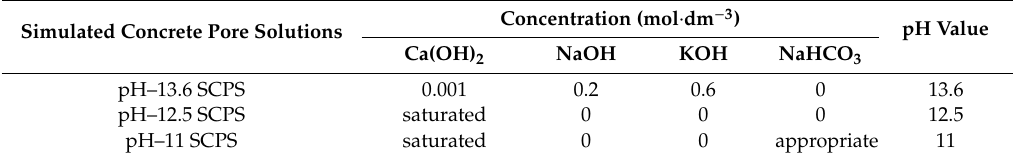
Table 2. Chemical compositions of the simulated concrete pore